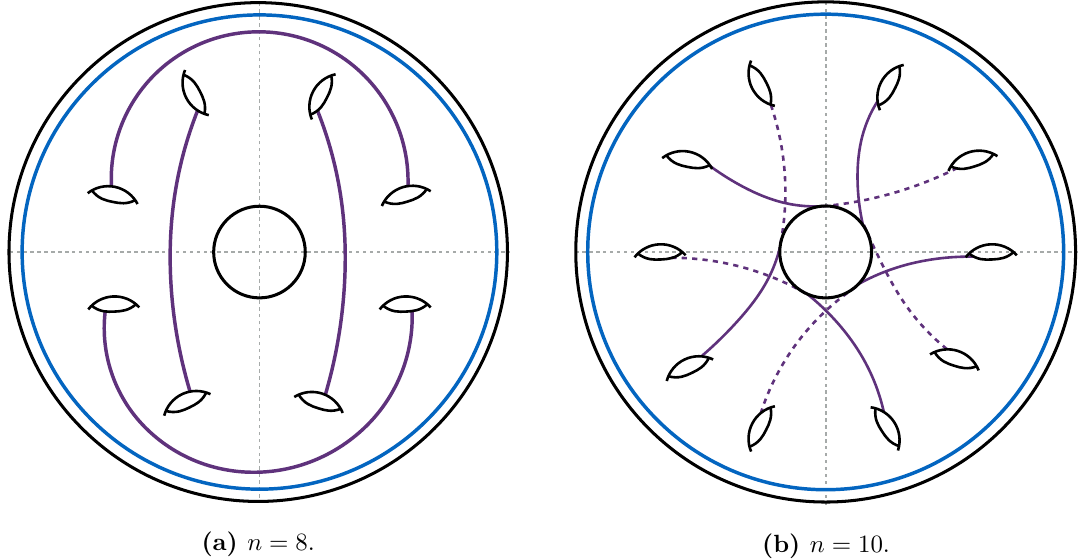
Figure 19 . A gapless phase for n = 8 and n = 10. The purple lines joining two holes i; j indicate the pair of cycles (cid:11) i (cid:0) (cid:11) j and (cid:12) i + (cid:12) j are contractible. Relevant re(cid:13)ection symmetries of the boundary are drawn in dashed grey. Both dashed lines on the left and the vertical dashed line on the right are possible t = 0 surfaces that can contribute to T n= 2 thought of as a state on H (cid:10) H . In contrast, the horizontal dashed line on the right gives a 4-boundary t = 0 surface.